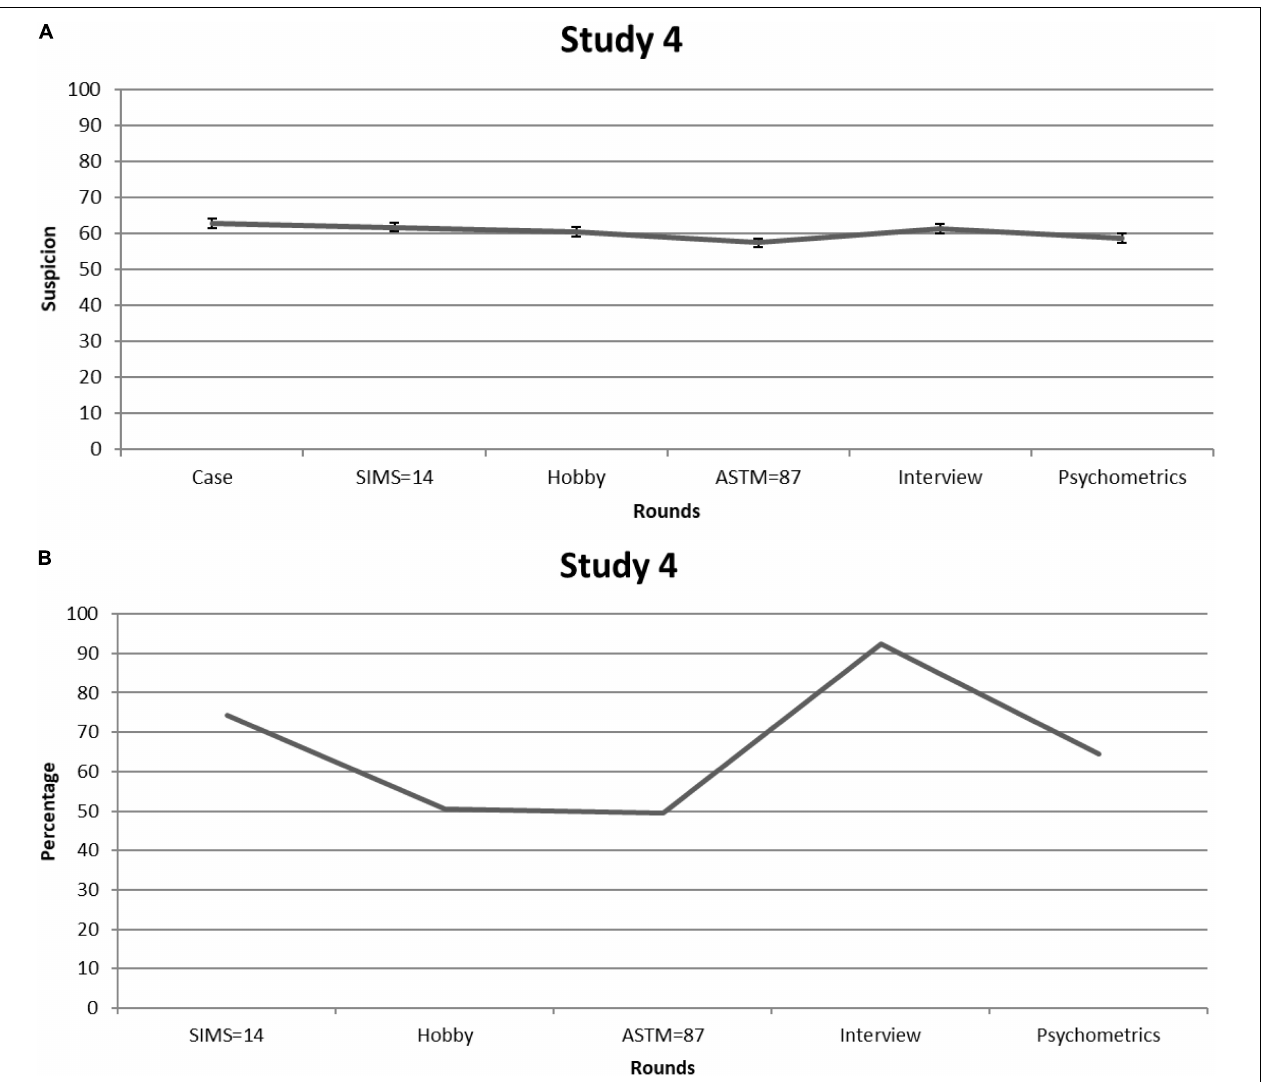
FIGURE 4 | Study 4. (A) Mean feigning x confidence ratings after each round of students who received information about the diagnostic and statistical manual for mental disorders (DSM’s) shortcomings and the importance of negative predictive power (NPP). Error bars are Standard Errors of the Mean. (B) Percentages of students (per round) who considered mentioning (possible) feigning as a conclusion in their